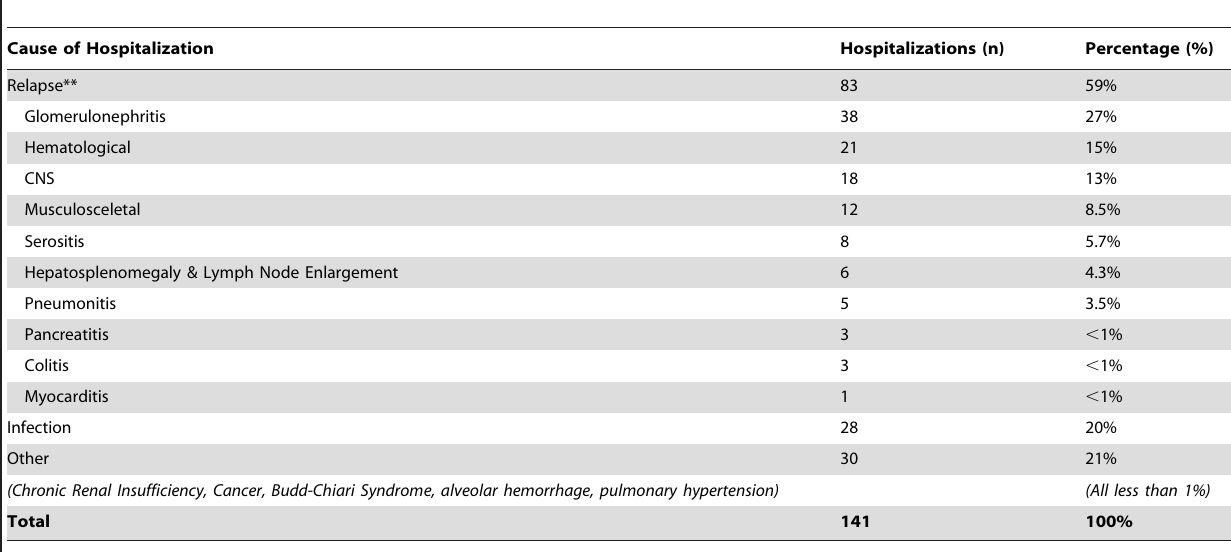
Table 2. Hospitalization causes of SLE patients during the 3 year follow up